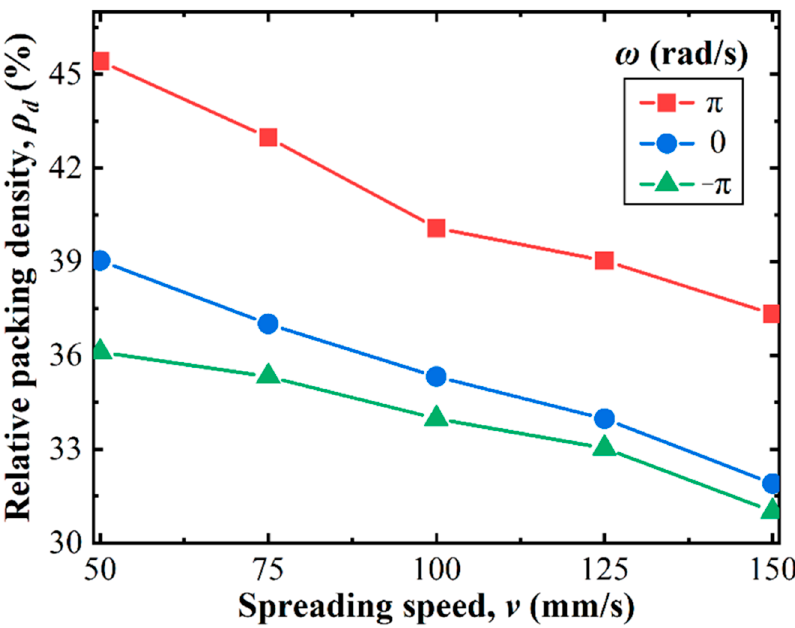
Figure 3. Evolutions of the powder bed packing density under different roller rotation patterns. The surface morphology of the powder bed under different roller rotation patterns is shown in Figure 4, where the powder bed profile is colored by the height value in the Z-direction. When the forward-rotating roller was used, as shown, the powder bed became thicker and smoother with fewer voids (i.e., the color of the powder bed becomes redder), meaning that more CF and PA12 powder particles were spread into the powder bed, thus increasing its density.